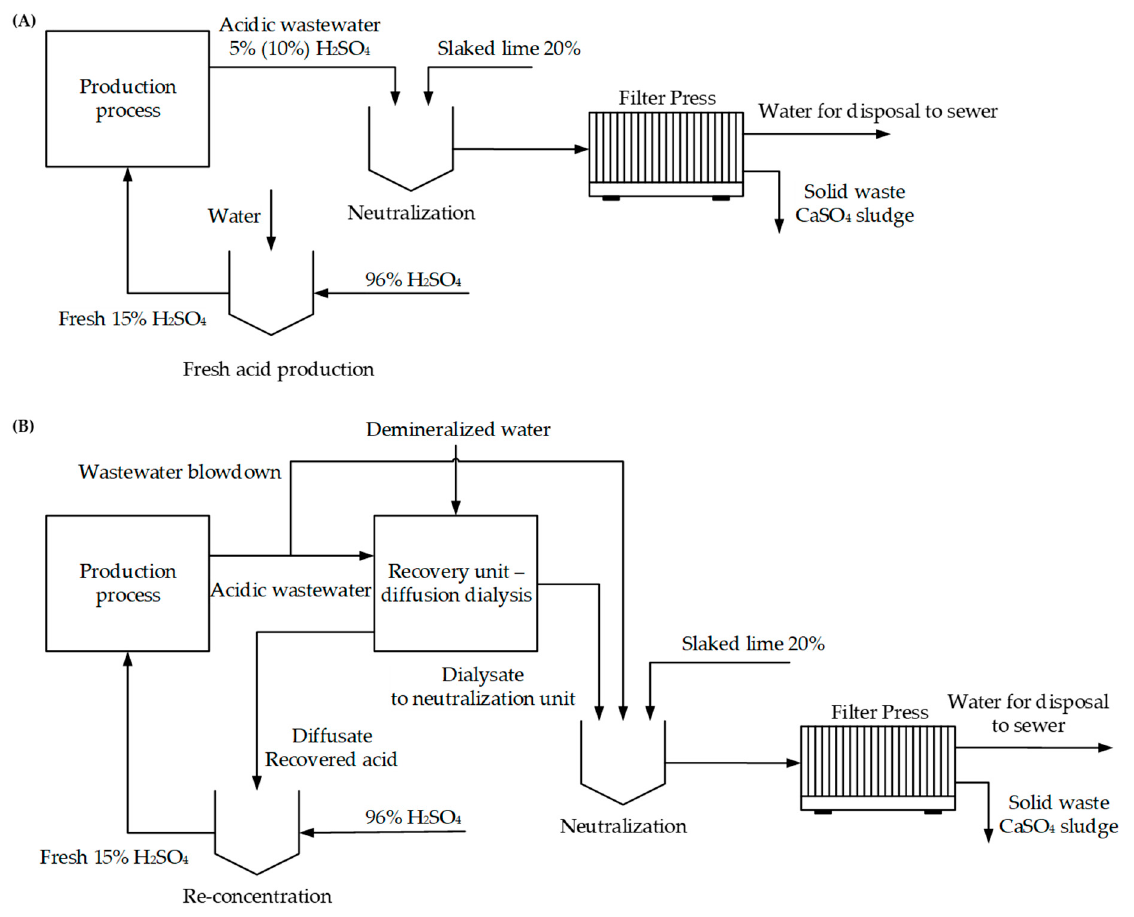
Figure 5. Process flow diagram for the proposed treatment technology. ( A ) treatment of acidic wastewater without diffusion dialysis; ( B ) implementation of dialysis into production-level wastewater management. Table 8. Unit costs of the considered sources. The price of electricity reflects the situation in the Czech Republic.